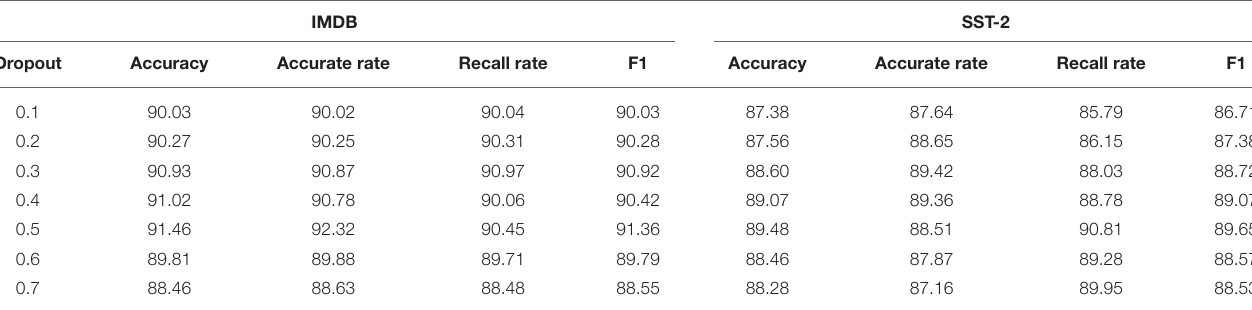
TABLE 5 | Experimental results of different Dropout values.